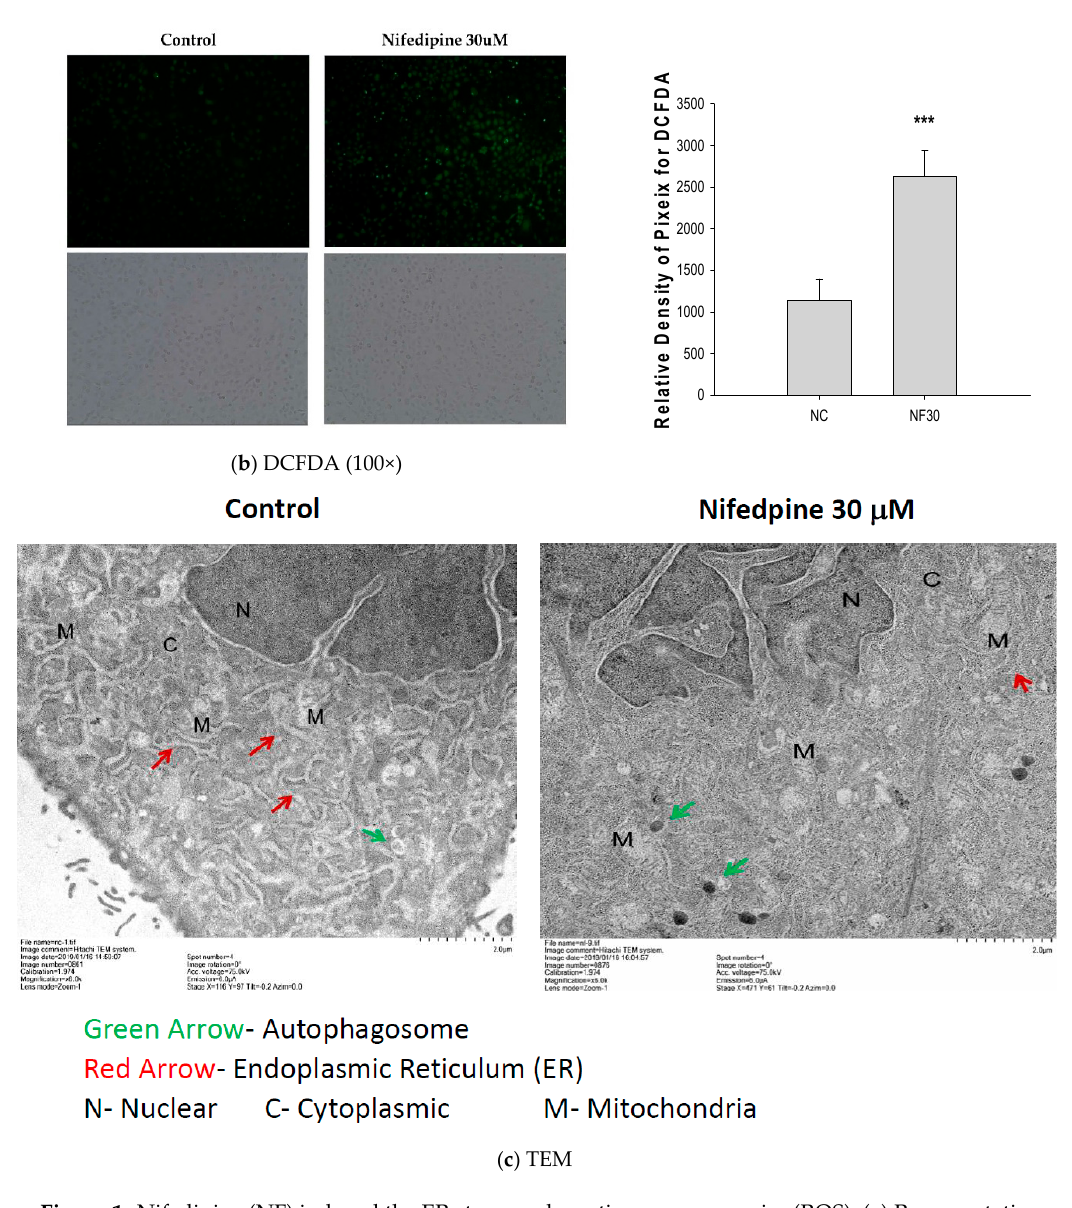
Figure 1. Nifedipine (NF) induced the ER stress and reactive oxygen species (ROS). ( a ) Representative images and quantitation of Thioflavin T staining for the detection of unfolded protein aggregates. Strong fluorescence appeared after treatment with NF (30 µM) for 6 and 8 h. Thapsigargin (TPS) (0.3 µM) was used as a positive control (100×). NC: normal control; NF30: nifedipine 30 µM; TPS0.3: thapsigargin 0.3 µM. * P < 0.1, ** P < 0.05, *** P < 0.01 compared to the normal control of 6 h. # P < 0.05, ## P < 0.05, ### P < 0.01 compared to the normal control of 8 h (n = 3). ( b ) Representative images and quantitation of DCFDA staining. The production of ROS induced by NF treatment (100×). *** P < 0.01 compared to the normal control (n = 3) . ( c ) Transmission electron microscopy (TEM) showing a vast population of autophagosomes, and less endoplasmic reticular folding appeared after treatment with 30 µM NF (6000×).